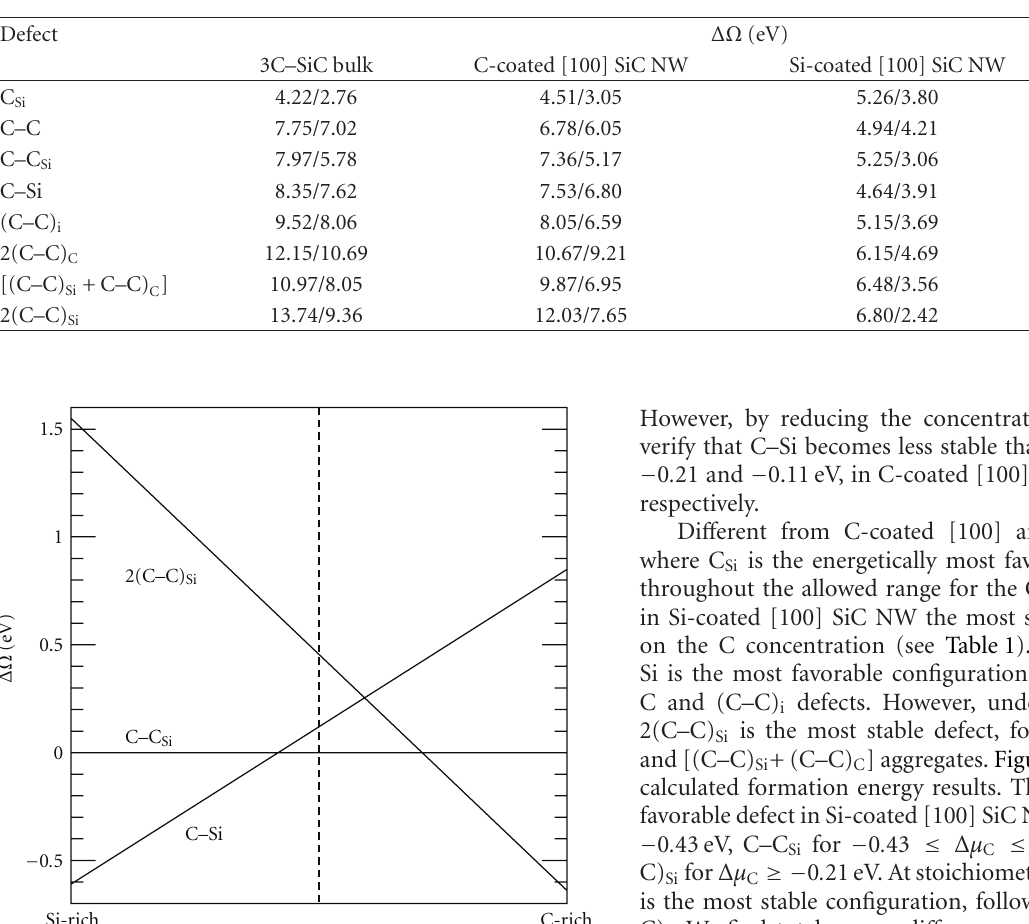
Table 1: Relative formation energies ( ΔΩ ) of carbon defects in 3C–SiC bulk, and hydrogen-passivated [100] and [111] SiC NWs. In each column the two values correspond to the Si-rich (or C-poor, where Δ µ C = − Δ H (SiC)) and C-rich ( Δ µ C = 0) limits (Si-rich/C-rich). The energies are in eV and we used Δ H (SiC) = 0 . 73 eV.